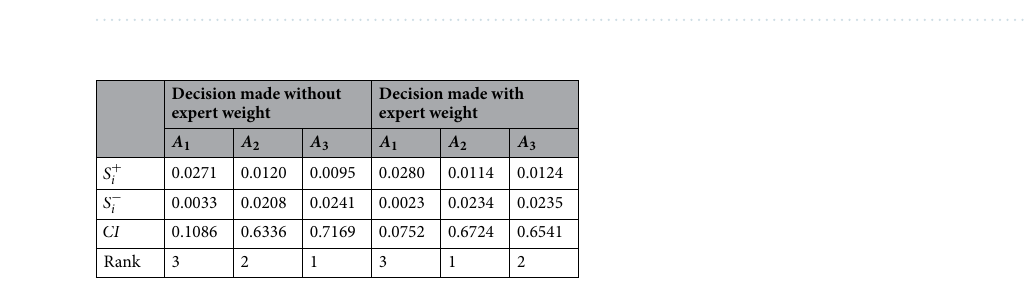
Table 11. Values of S + i , S − i , CI with and without expert weight.